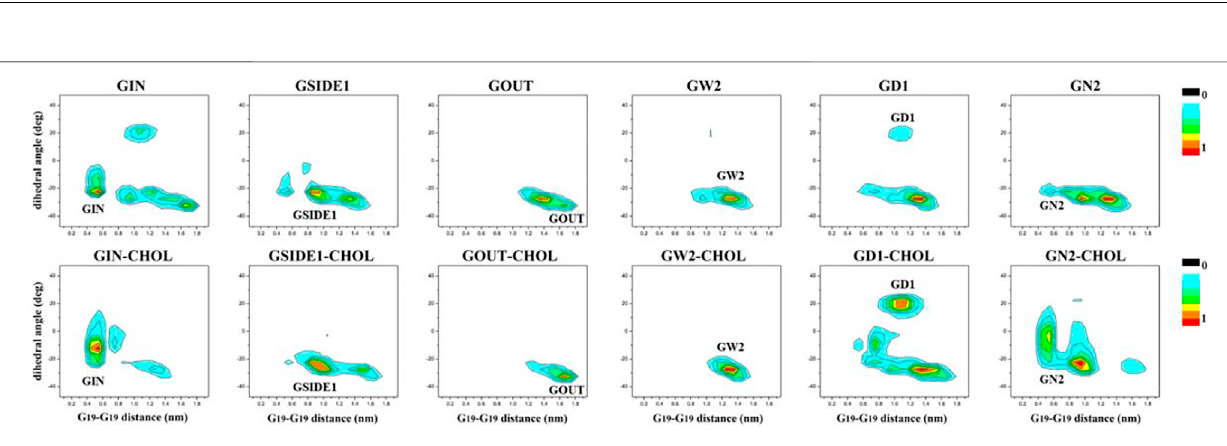
FIGURE 4 | The conformation distributions for C99 homodimer from the simulations starting with six representative conformations in DPPC bilayer were projected onto the two parameters of Ω and G − G. The top panel is the distribution of C99 dimer when without cholesterol, whereas the bottom panel is the distribution when with 20% cholesterol. The representative structures are labeled in the corresponding